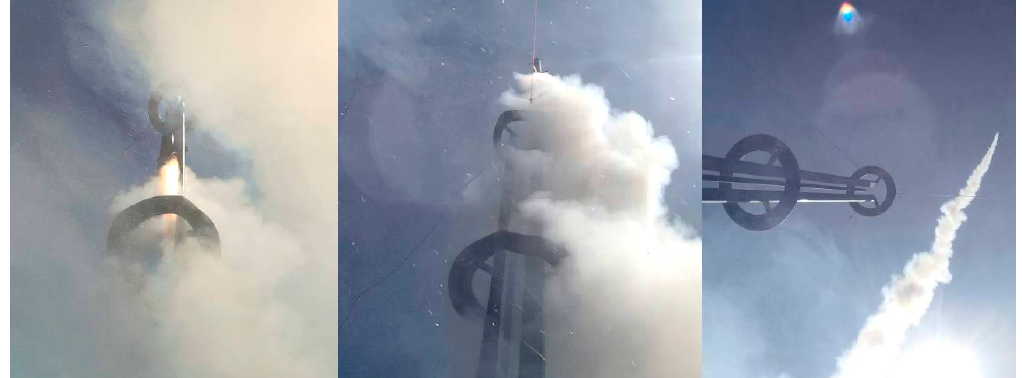
Figure 25. Sequence of stills showing Tasha III rocket moving up and leaving launch guide.